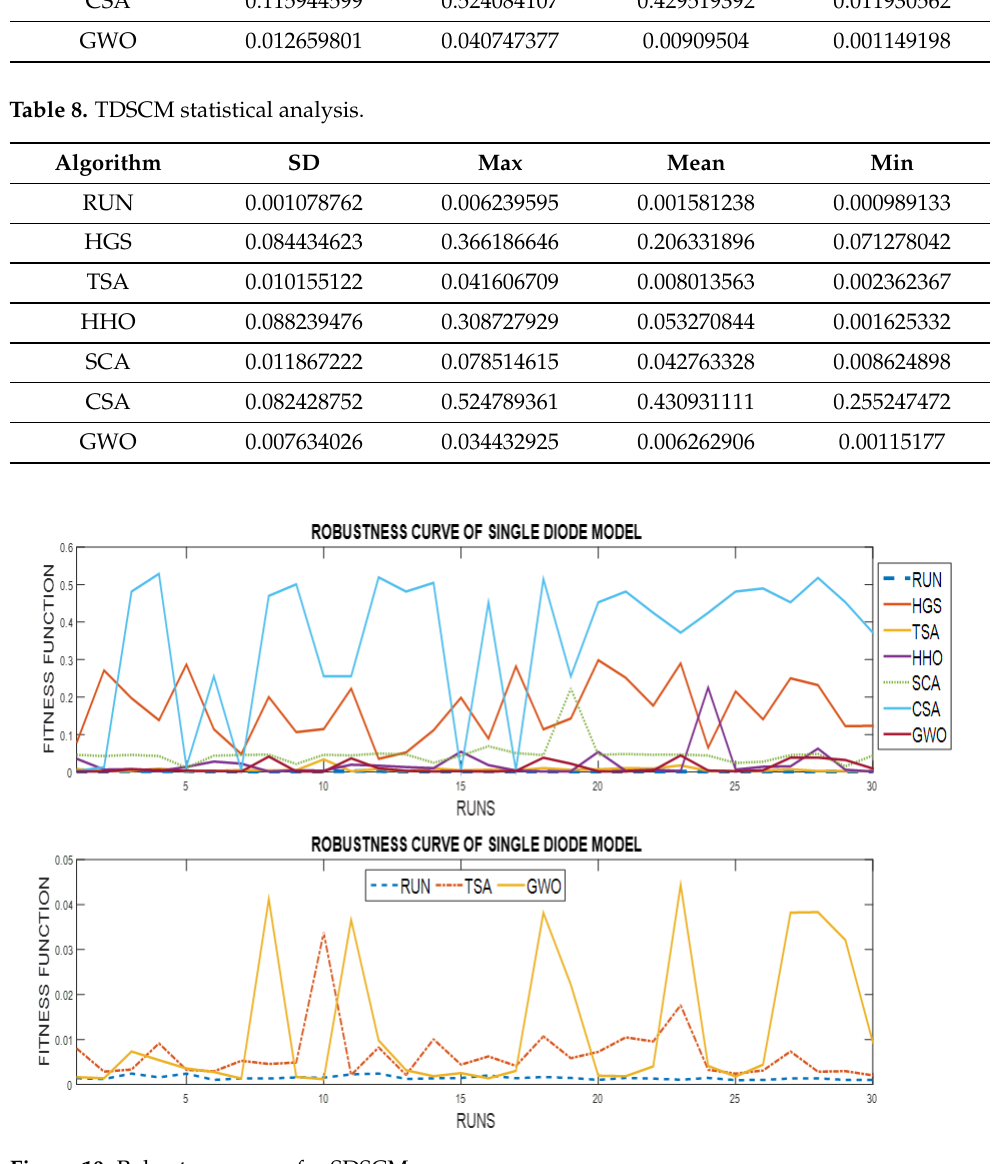
Figure 10. Robustness curve for